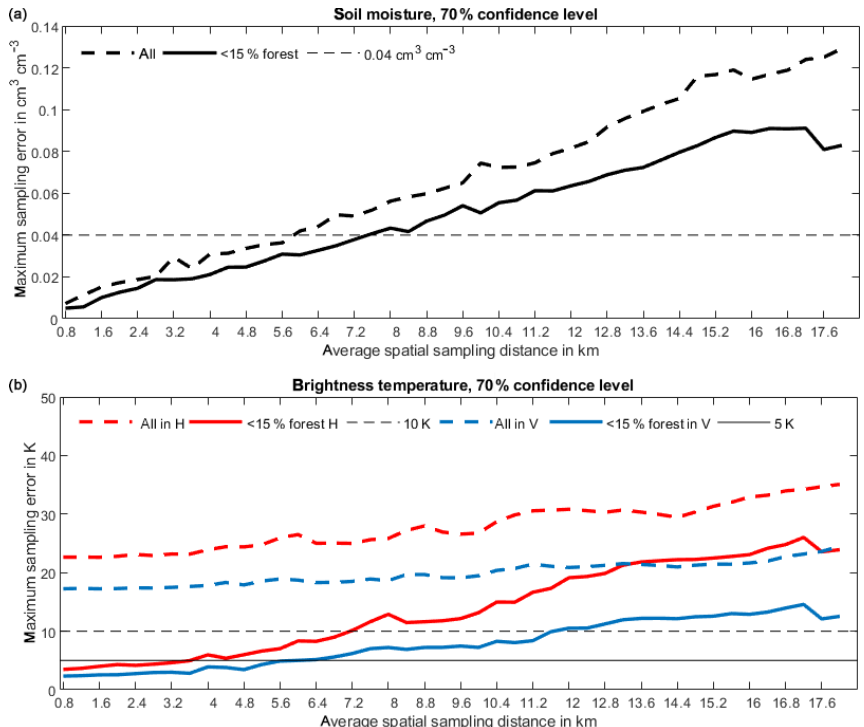
Figure 11. The maximum sampling errors of the arithmetic mean of soil moisture (a) and brightness temperature (b) estimated from all sites and from sites with forest cover below 15% against average sampling